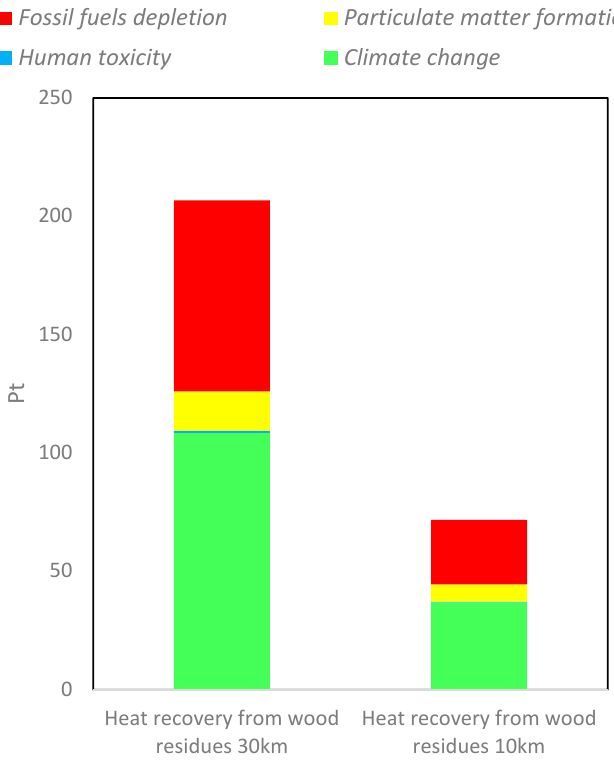
Figure 7. Single score assessment: comparison between the traditional wood-based scenario with the scenario with less km, for the production of 1 MWh of thermal energy.